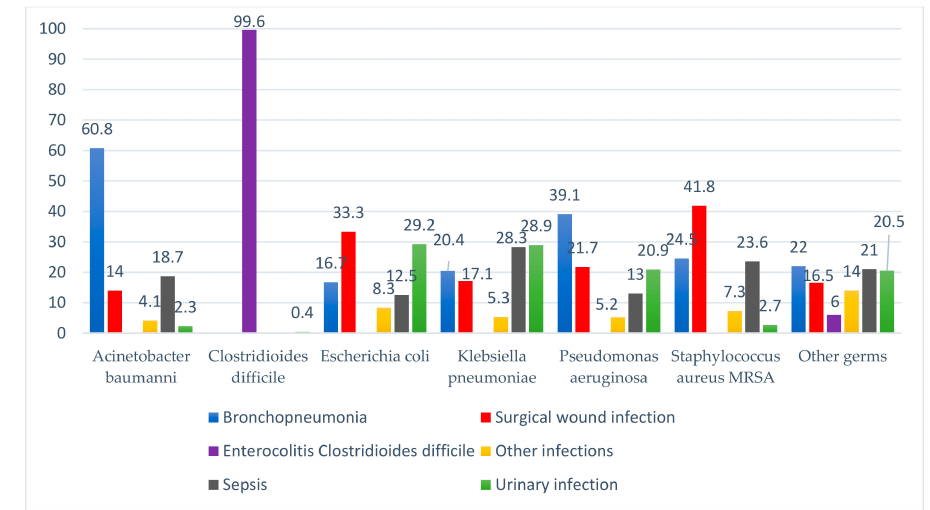
Figure 2. Diagnosis of HAI and type of pathogen.